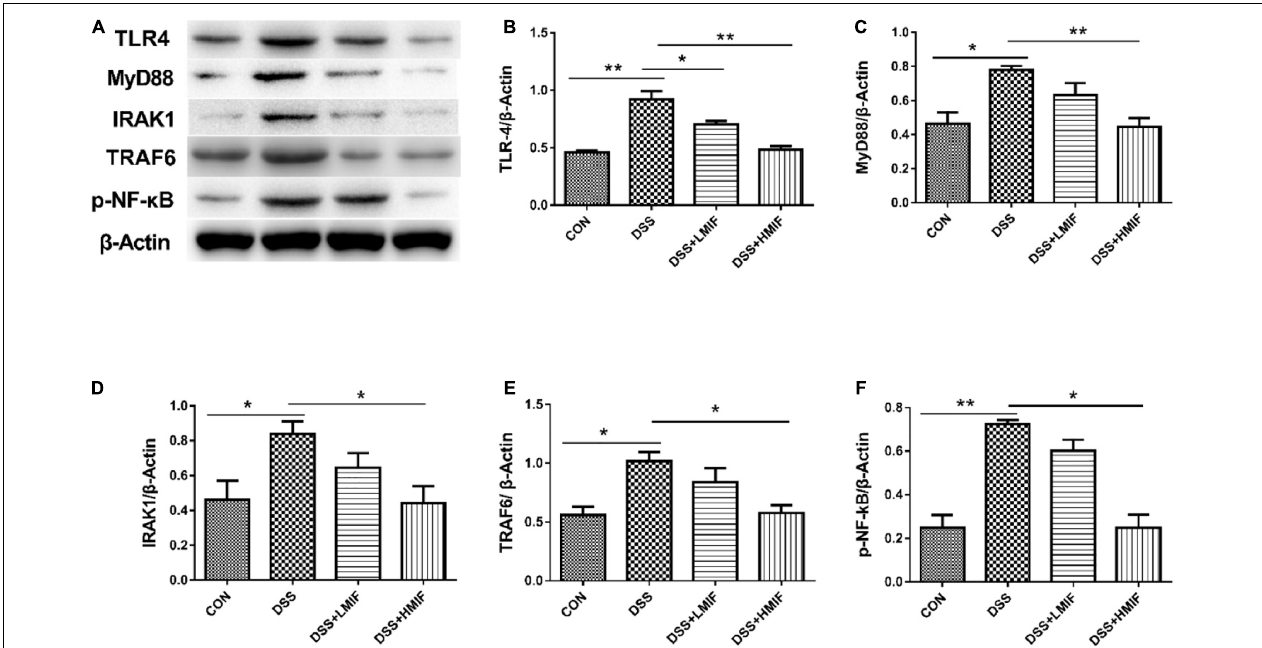
FIGURE 4 | Effects of Morchella importuna flavones on the abundances of the colonic Toll-like receptor 4 (TLR4) signaling pathway-related proteins in dextran sulfate sodium (DSS)-challenged mice. (A) Representative Western blot picture; (B) TLR4; (C) MyD88; (D) IL-1 receptor-associated kinase 1 (IRAK1); (E) TNF